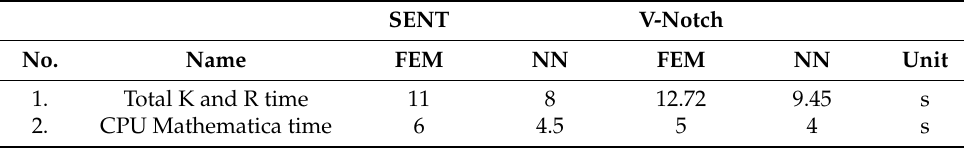
Table 6. SENT and V-notch tests—AceFEM Simulation